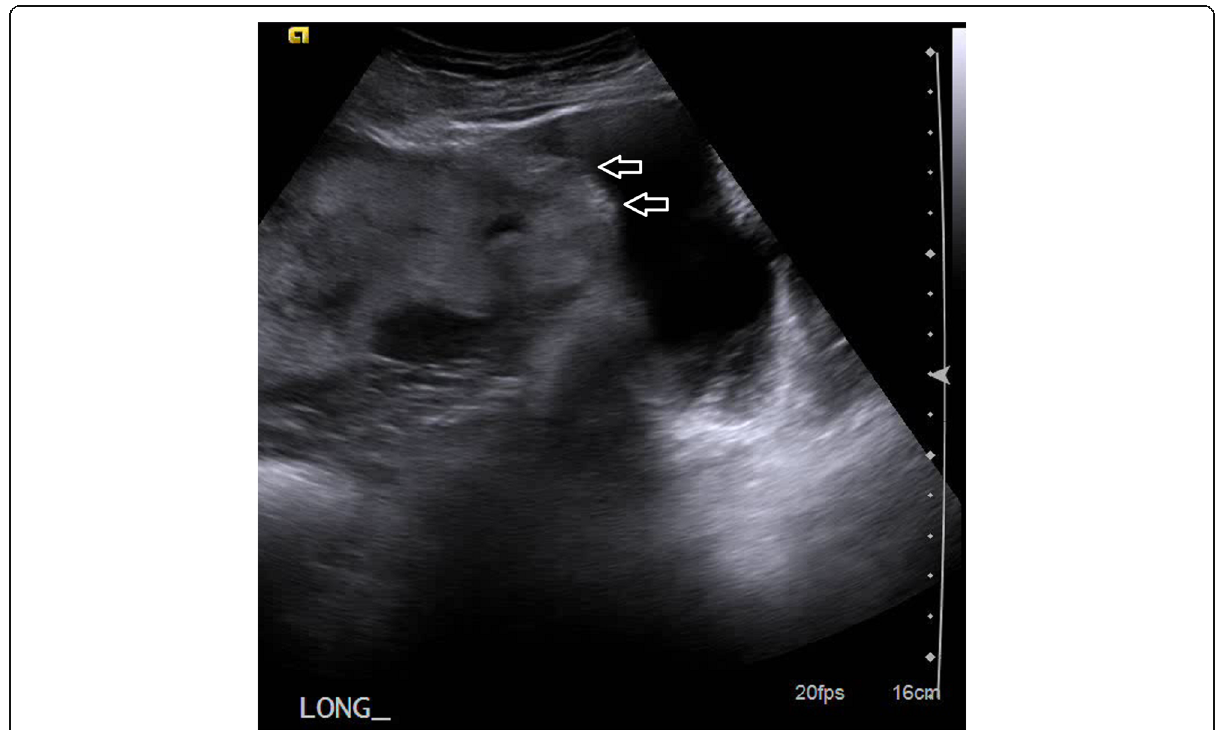
Fig. 4 Grey scale sonographic image showing many of the features of PAS, including loss of the retroplacental hypoechoic zone, retroplacental myometrial thickness < 1 mm, and a lower uterine segment echogenic “ bulge ”